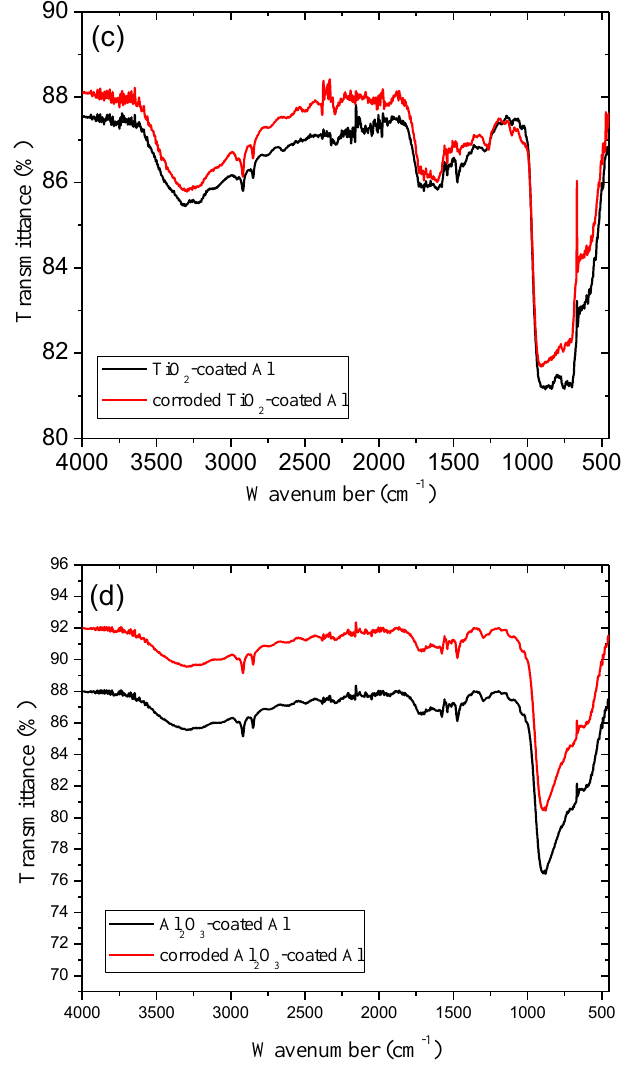
Figure 3. FT-IR spectra of the studied samples in the condition of as-deposited and after corrosion process. ( a ) control or bare Al, ( b ) commercial resin-coated Al, ( c ) TiO 2 -coated Al, ( d ) Al 2 O 3 -coated Al.